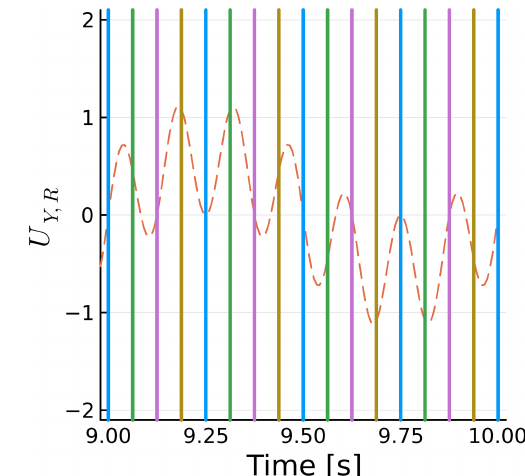
Figure 22. Time history of blade 1 streamwise blade tip yaw veloc- ity. Vertical lines show blade azimuth.